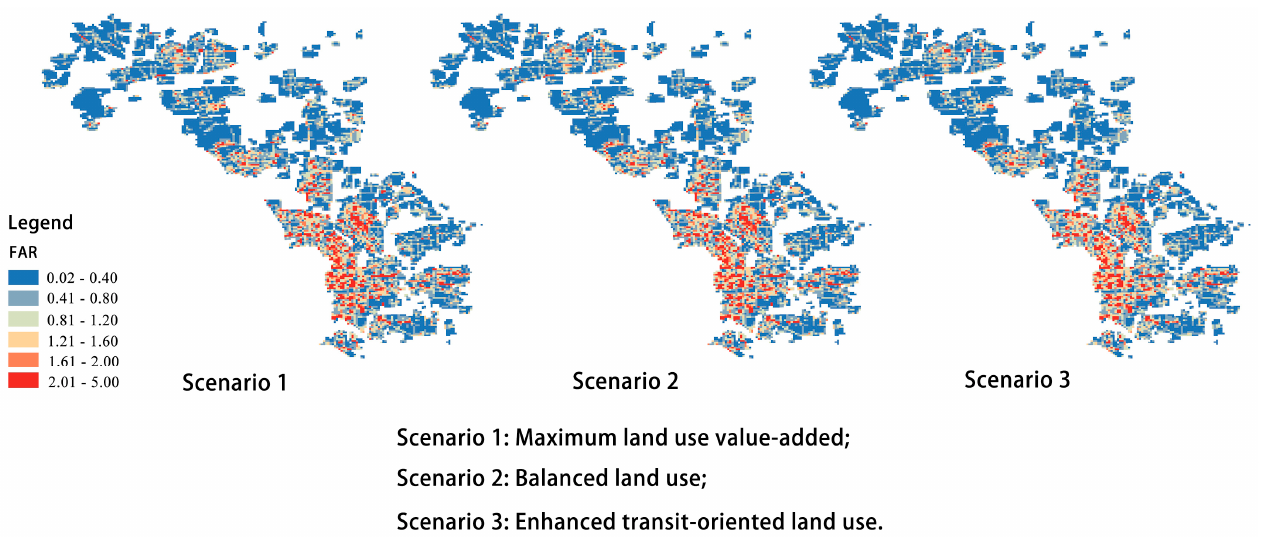
Figure 3. “Theoretically ideal” FAR distribution in the three scenarios.